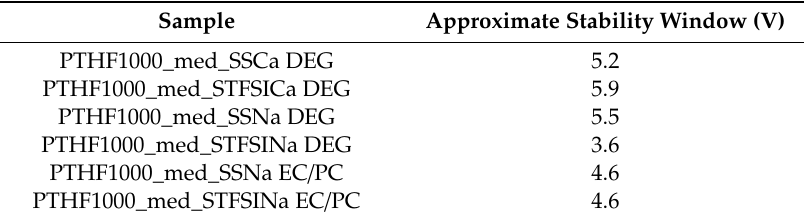
Table A2. Electrochemical stability window for tested SIPEs. Configuration is stainless steel /